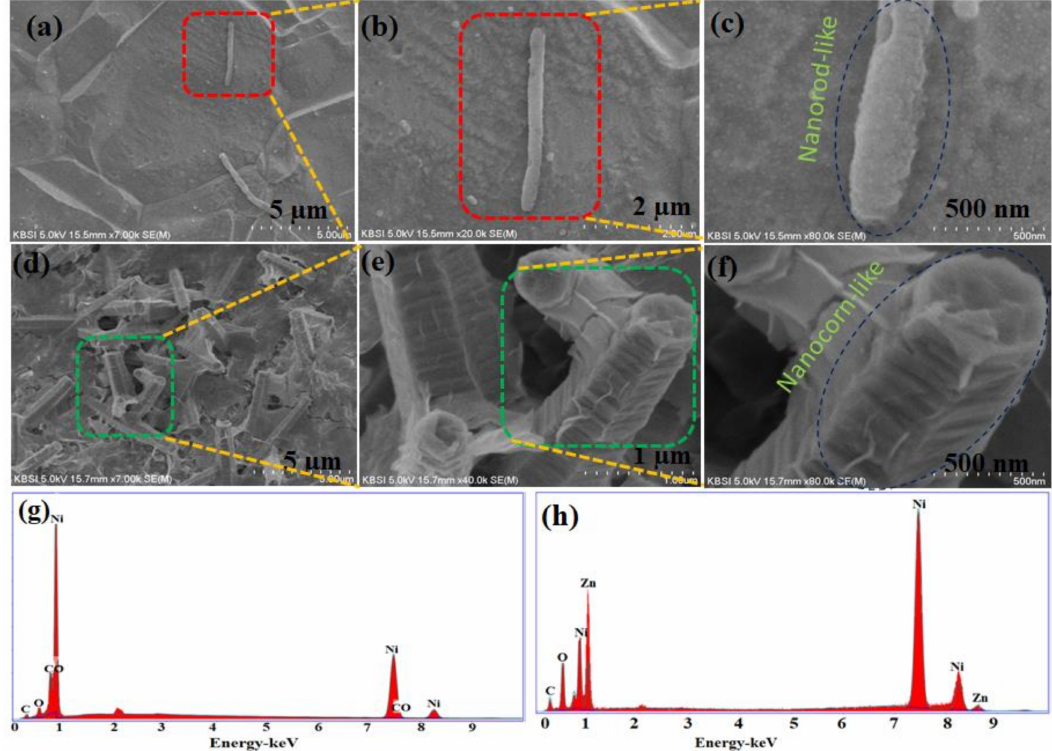
Figure 2. Low and high-magnification Field emission-scanning electron microscopy (SEM) images of the ( a – c ) CoO nanorod structures and ( d – f ) ZnO nanocorn structures and the energy-dispersive X-ray spectroscopy (EDX) pattern of CoO and ZnO ( g , h ) nanostructures on Ni